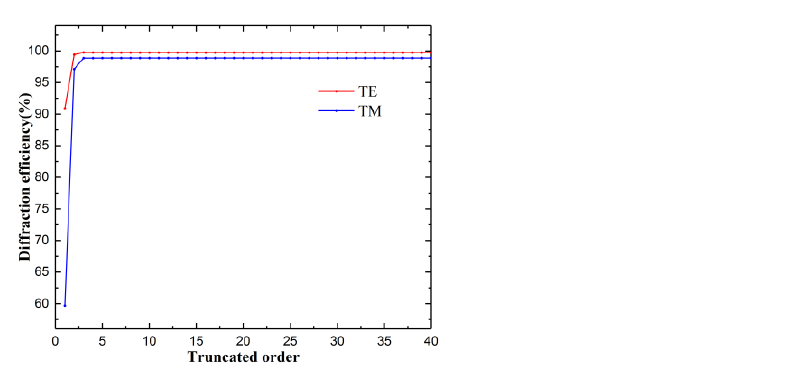
Figure 2. Diffraction efficiencies of − 1st order varied with the truncated order 𝑚 for TE and TM polarizations at 1053 nm of the designed grating.